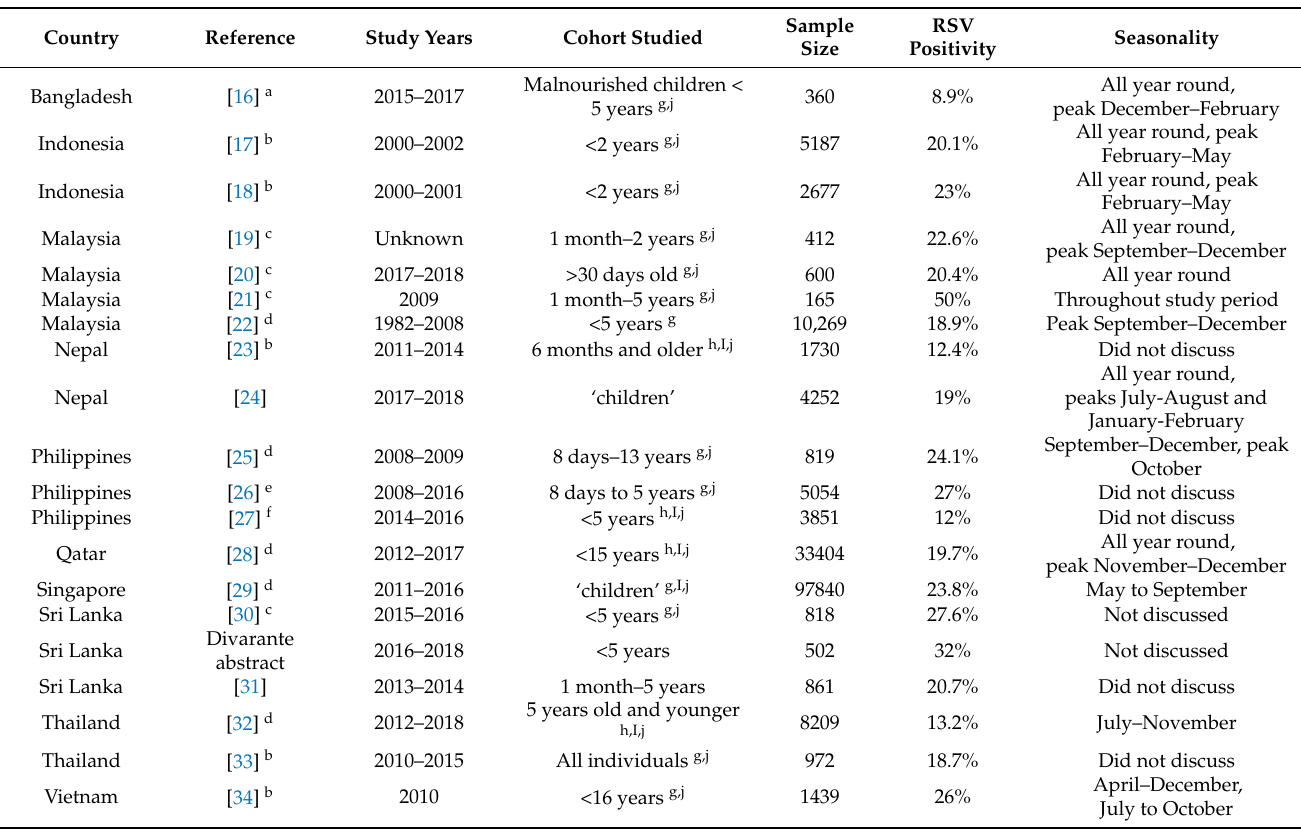
Table 1. Respiratory syncytial virus (RSV) epidemiology in countries of tropical